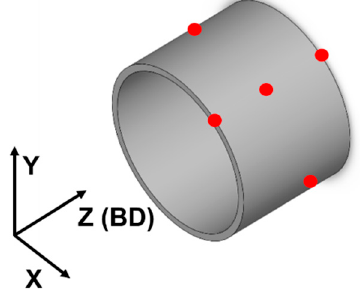
Figure 4. Isometric view of the tube showing all three directions. The red pointers represent the locations where surface roughness evaluation was